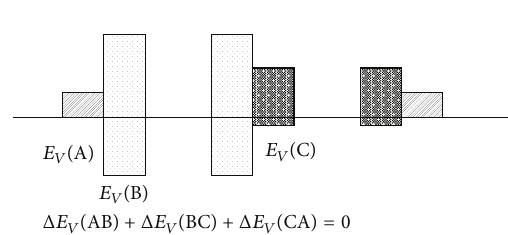
Figure 36: Schematic representation of the valence band offset Δ𝐸 𝑉 transitivity principle in semiconductor